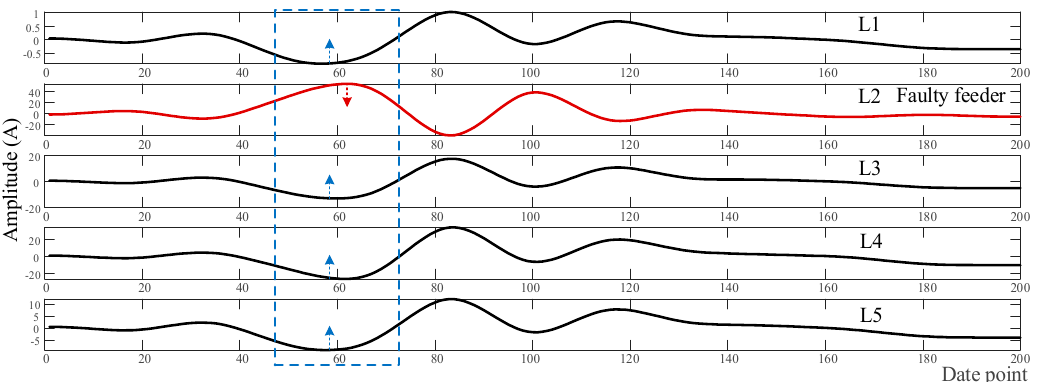
Figure 10. Transient characteristic waveforms extracted at (4, 0) node when R d = 0 Ω , φ = π /2.